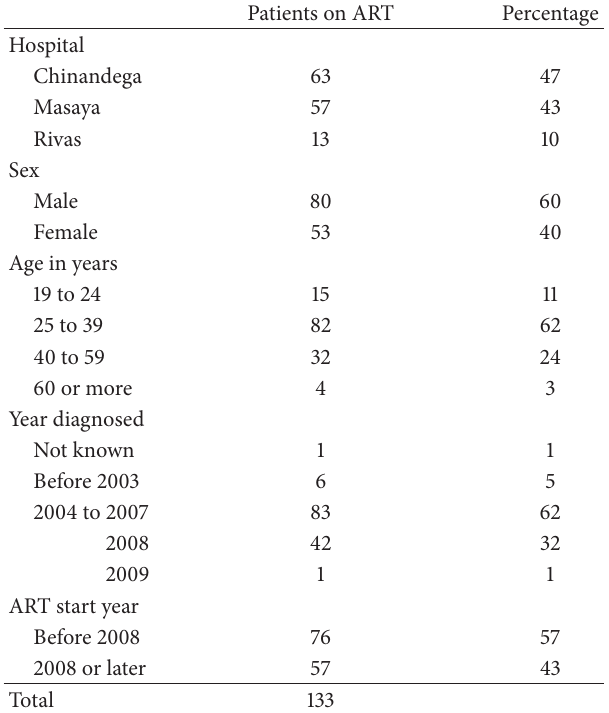
Table 1: People with HIV on ART per hospital, gender, and year